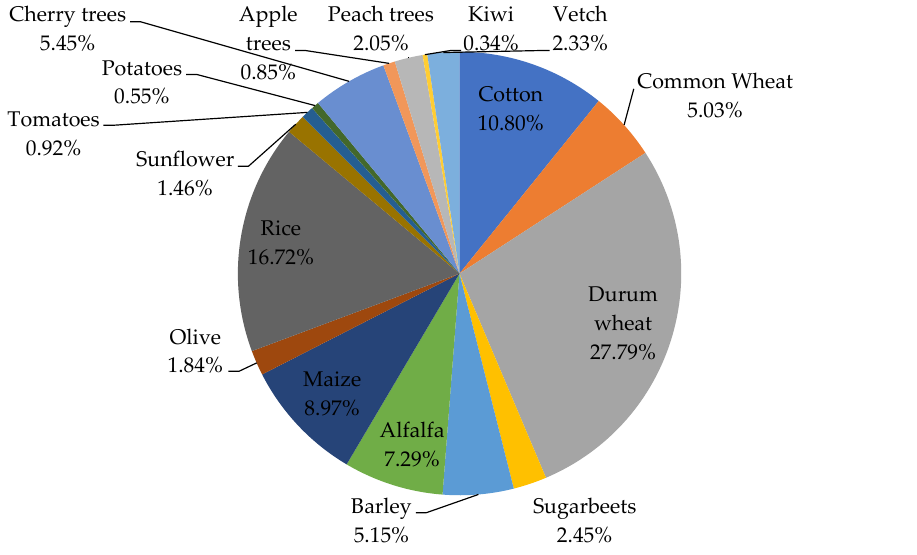
Figure 2. Real Situation Crop Plan for the average farm. Source: Hellenic Statistical Authority.